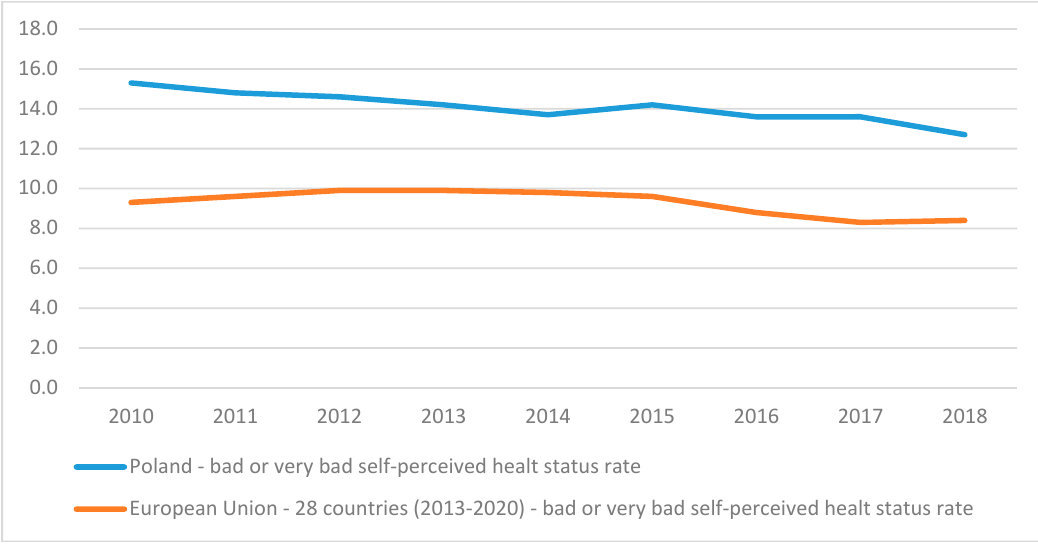
Figure 3. Self-perceived health status reported by Polish citizens at the background of the EU average—based on (Eurostat 2019c).